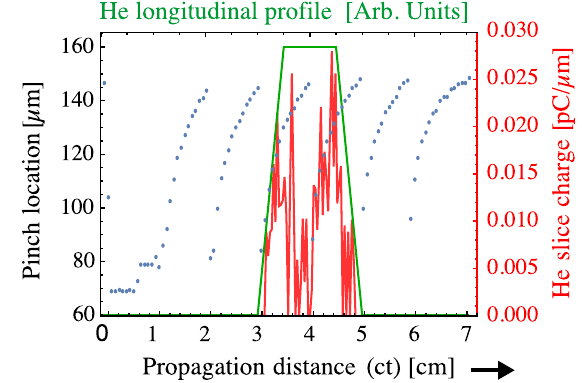
FIG. 3. Plot of the numerical data points for the local minima of the driver envelope (pinch — blue dots) along the propagation distance, ct , for each slice in ξ ¼ z − ct , from the control simulation. Red line corresponds to the charge released at the pinch location of each ct position, inside the He neutral gas section. Longitudinal He profile is illustrated by green